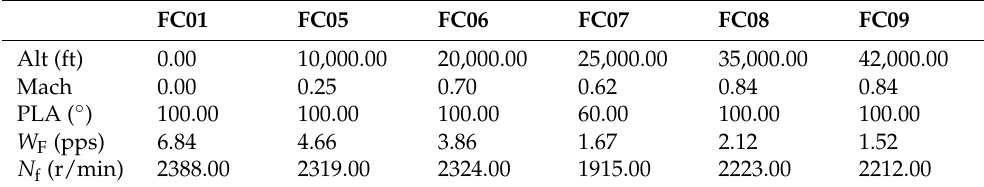
Table A1. Six published flight